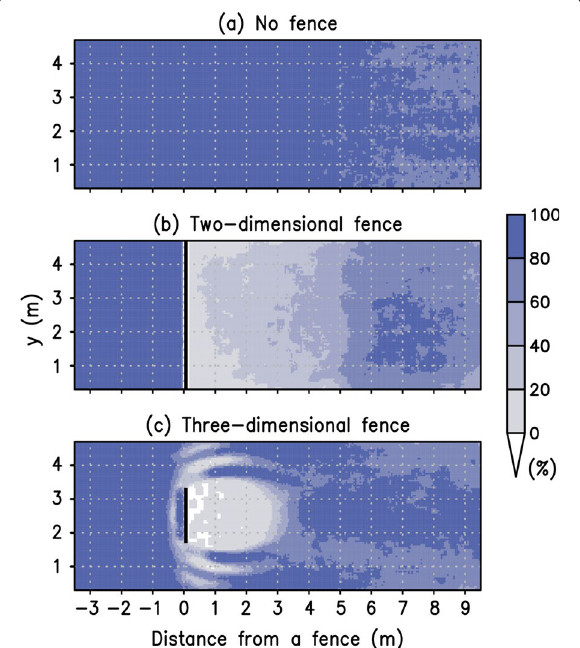
Fig. 13 Snowdrift potential a for no fence, b around the two-dimensional fence, and c around the three-dimensional fence. The position of the fence is shown by a solid